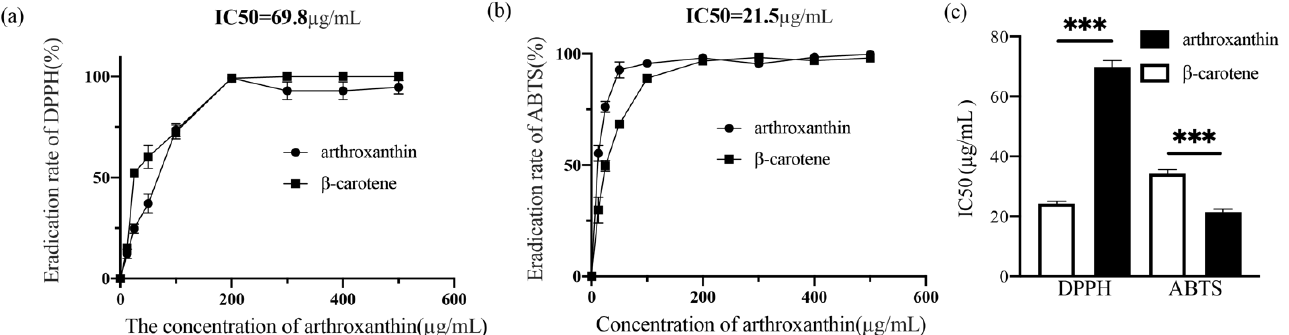
Figure 4. ( a ) DPPH radical scavenging activity of arthroxanthin. ( b ) ABTS radical scavenging activity of arthroxanthin. ( c ) IC 50 values of β -carotene and arthroxanthin in different radical scavenging activity assays. *** p < 0.001 compared with β -carotene.